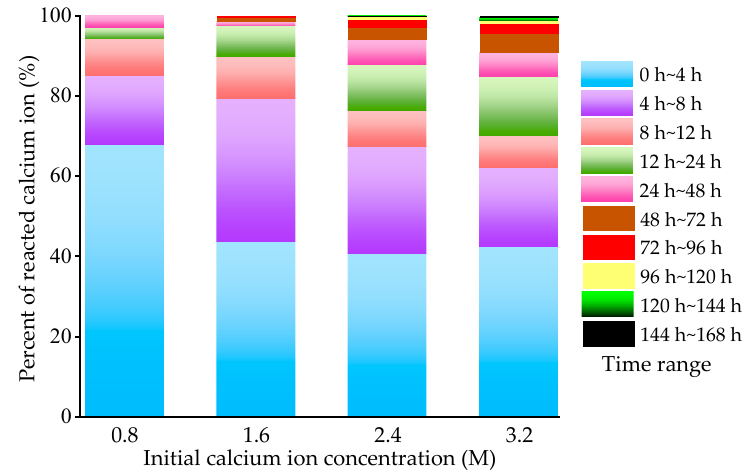
Figure 3. Change in residual calcium ion concentration and precipitation mass in different concentrations of cementation solutions.